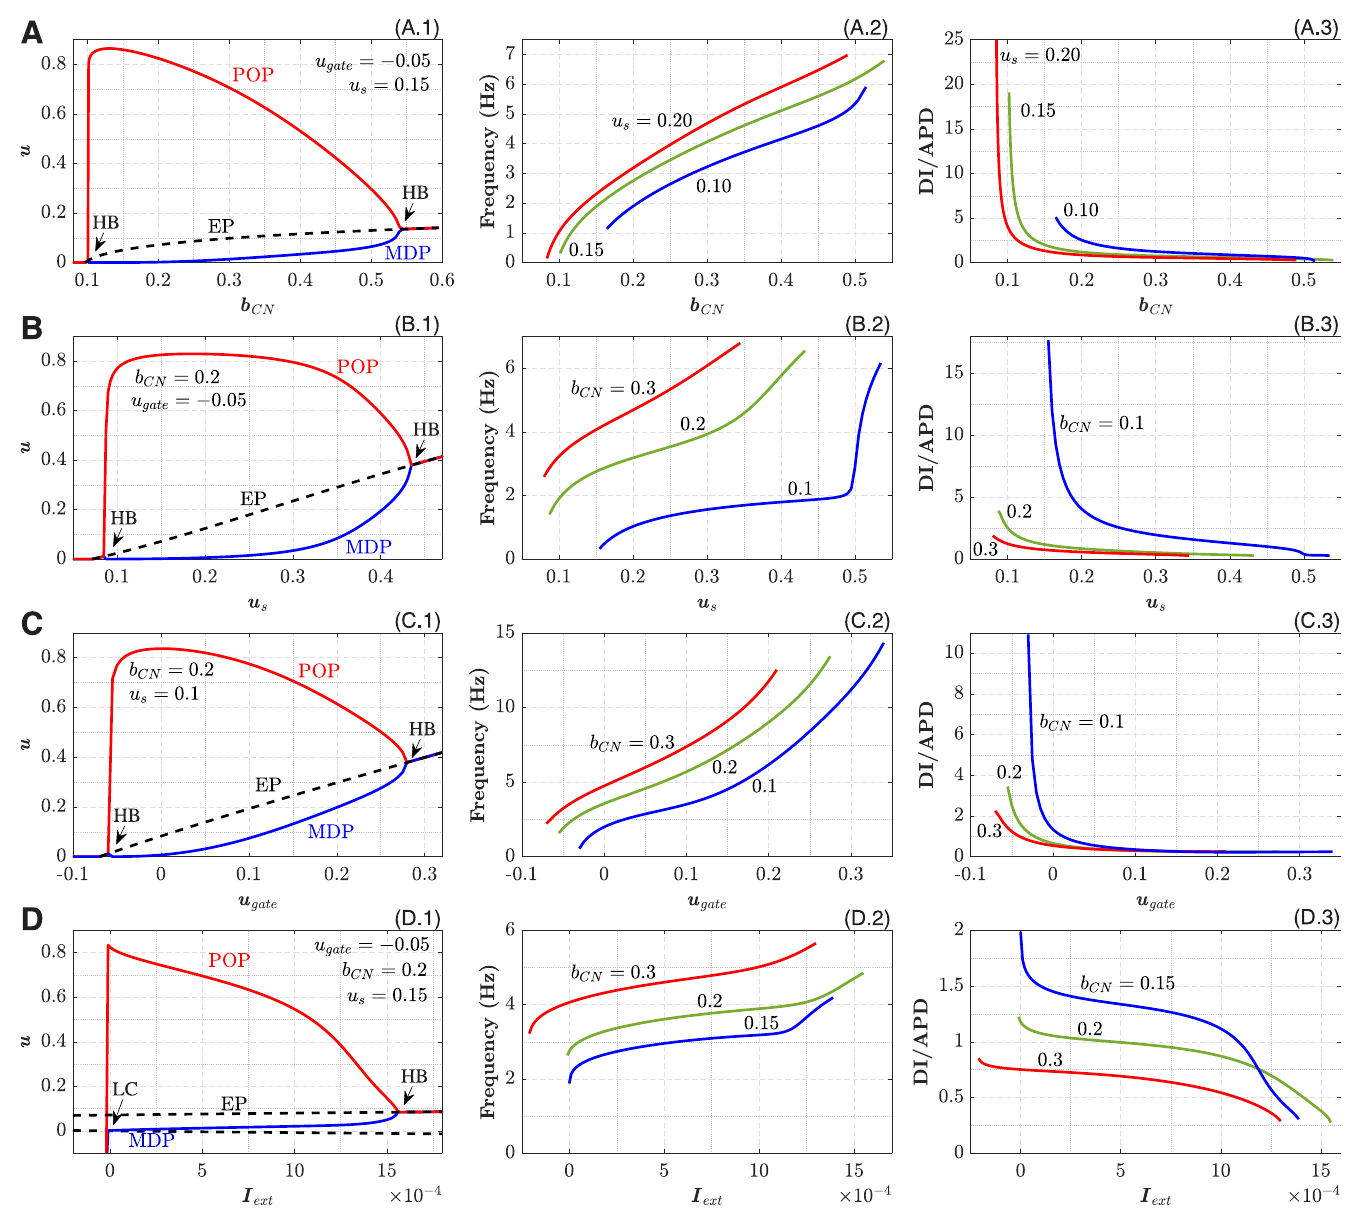
Fig 5. Dependence of pCN cell characteristics on various parameters. A. On the bifurcation parameter b On the external current I ext . Left panels correspond to the bifurcation diagrams, central—to the calculated frequencies, and right panels—to the calculated DI on APD ratios.